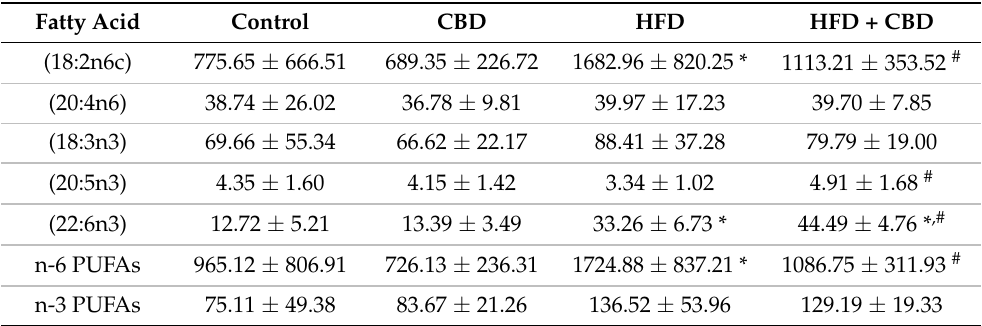
Table 6. Polyunsaturated fatty acids (PUFA) content in the TAG fraction (nmol/g of wet tissue) in the red gastrocnemius muscle in the control (standard diet) and high-fat diet (HFD) groups after two-week cannabidiol (CBD)